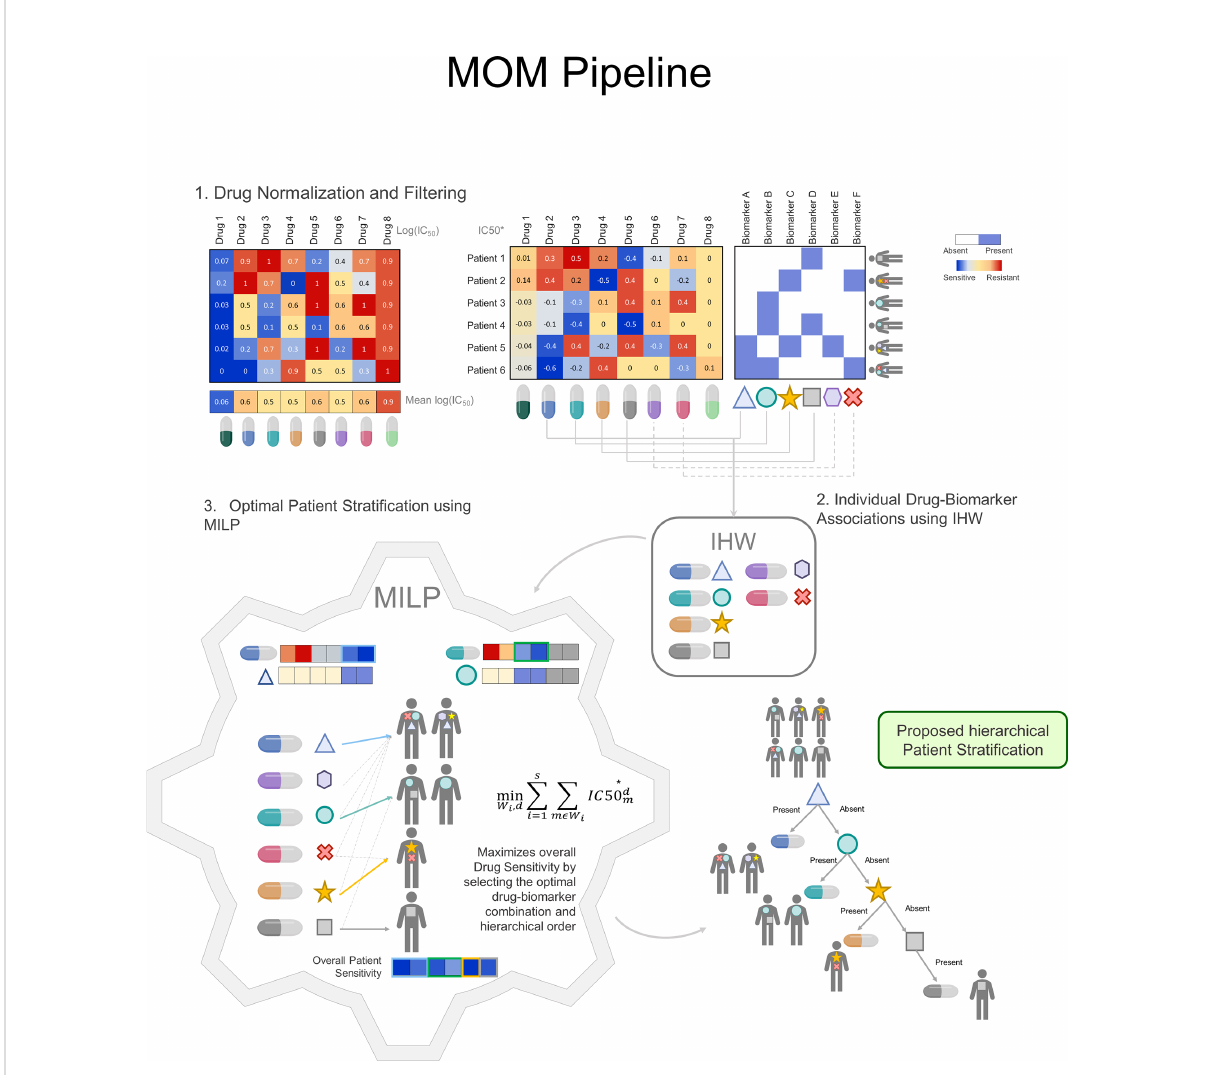
FIGURE 2 MOM Pipeline: MOM pipeline is de fi ned by 3 major steps: 1 ) Drug normalization to reduce drug toxicity. It is performed by removing drug mean effect in all patients. The blue color represents drug sensitivity for the sample whereas the red color represents drug resistance in the sample. 2) Individual Drug biomarker associations using IHW. Drugs are matched to biomarkers pro fi le, all individual associations generate a p-value that is corrected using IHW. IHW selects the candidate biomarkers and treatment and are used as input to the MILP problem. 3 ) Optimal Patient Strati fi cation using MILP. The MILP module receives as input the normalized drug information IC50* and the candidate individual associations and outputs a decision tree for clinical decision-making guidance. Within this module, the treatment is optimized so that each patient receives the drug for which is more sensitive. (IHW: Independent Hypothesis Weighting, MILP: Mixed-Integer linear